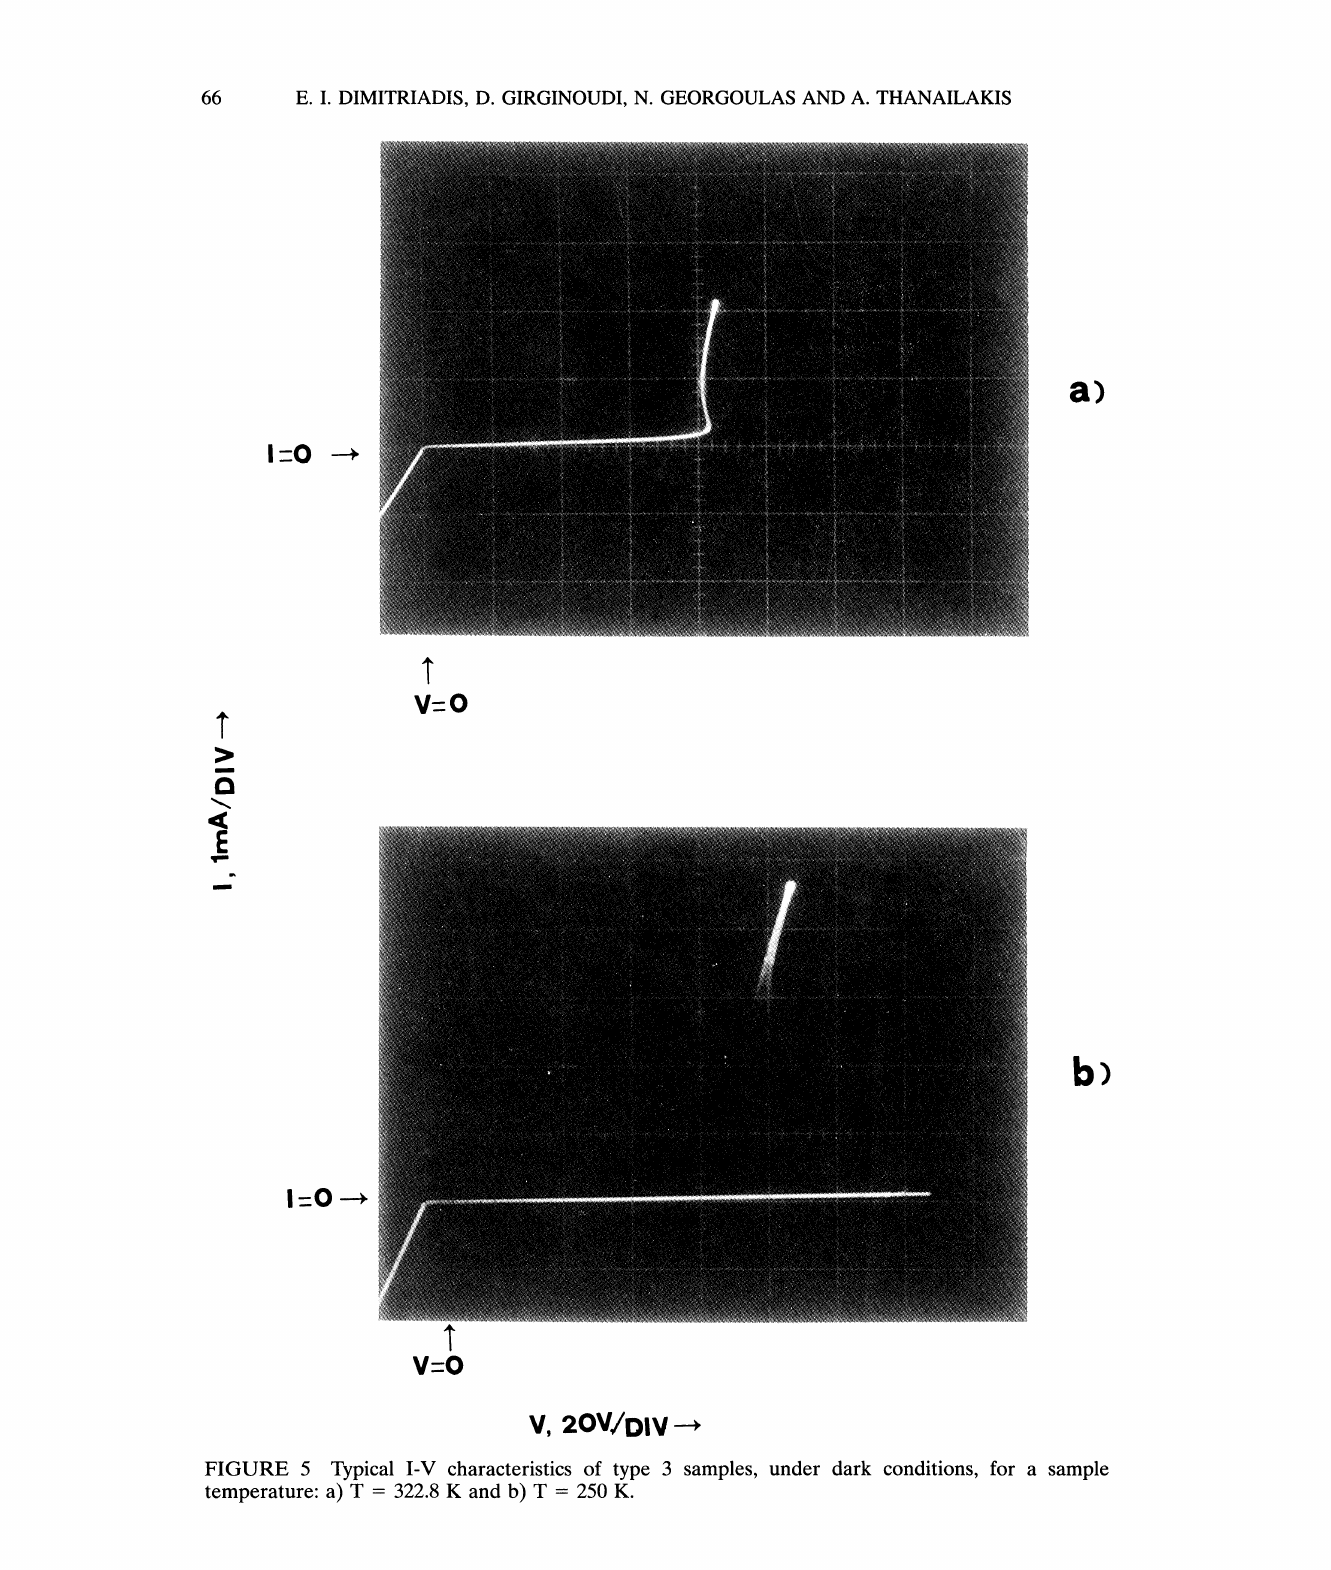
FIGURE 5 Typical I-V characteristics of type 3 samples, under dark conditions, for a sample temperature: a) T 322.8 K and b) T 250